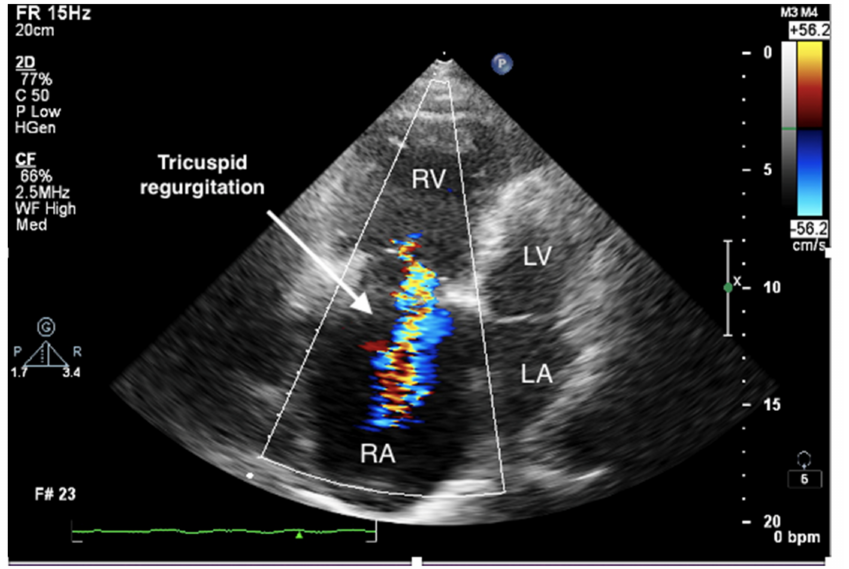
Figure 4. Enlarged right ventricle and right atrium. Tricuspid regurgitation. 2D-TTE, RV-focused apical 4CH